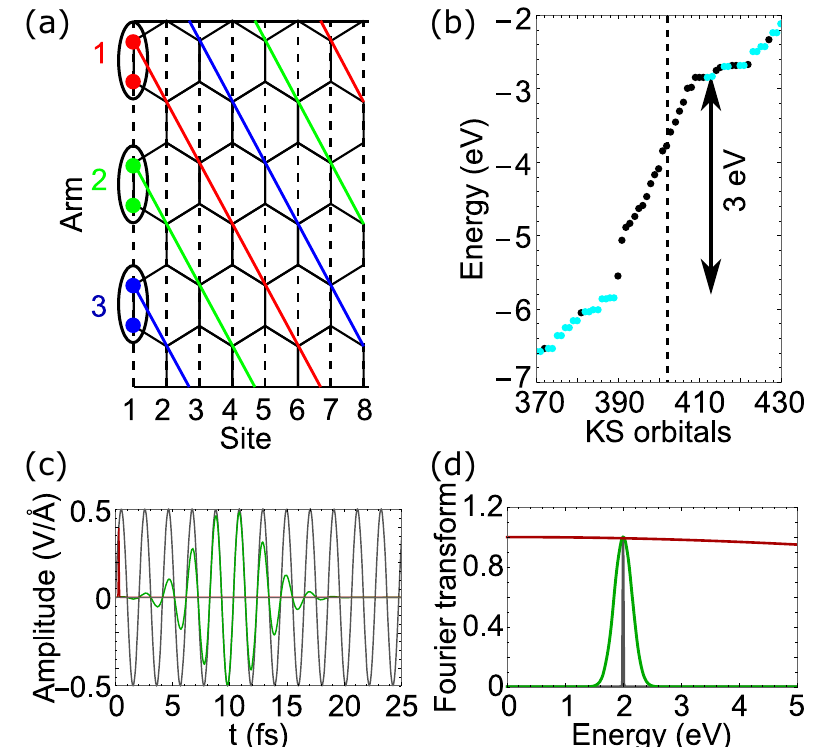
Fig. 6 The (3, 3) CNT. a Decomposition of the (3, 3) CNT into a spiral of 3-arm sites. b Energies of the KS orbitals. The 402 nd is the highest occupied KS orbital. Orbitals with OAM = 0 and ±1 are shown in black and cyan, respectively. c Laser pulses with E 0 = 0.5 V/ Å , ℏ ω = 2 eV, and envelope function exp ð(cid:4)ð t (cid:4) 0 : 3fs Þ 2 = 2 ð 0 : 03fs Þ 2 Þ (red) or exp ð(cid:4)ð t (cid:4) 10fs Þ 2 = 2 ð 3fs Þ 2 Þ (green). The gray curve is 0 : 5sin ð ω t Þ . d Normalized Fourier transforms of the curves in c